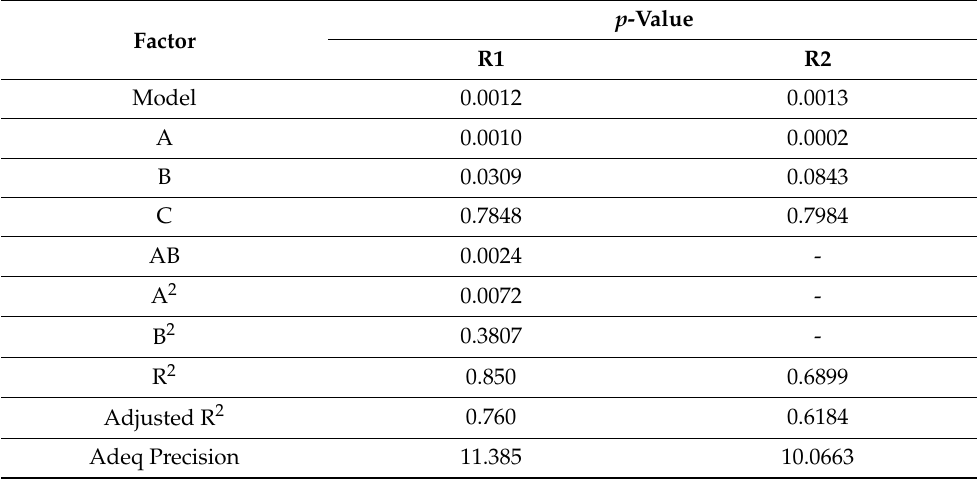
Table 3. Significance of each factor equation model terms of the TYR/CS